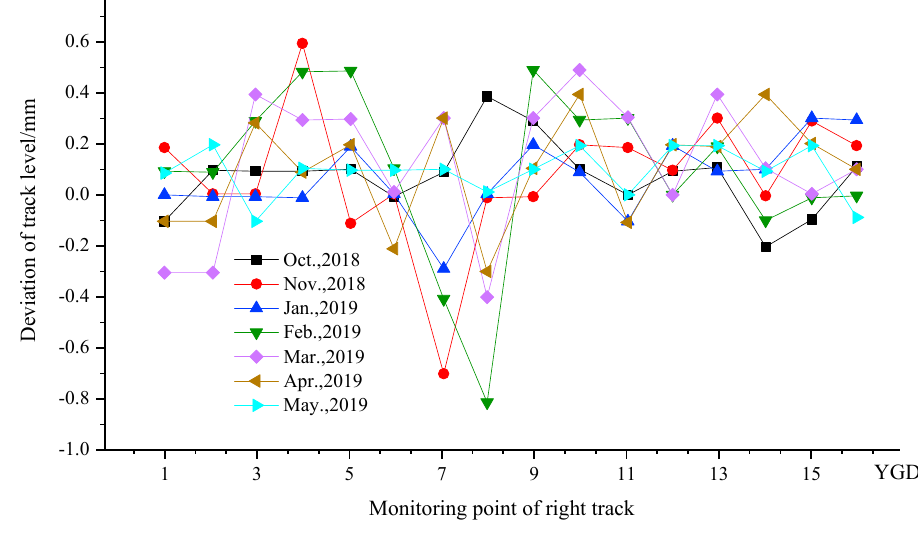
Figure 16. Right track level.